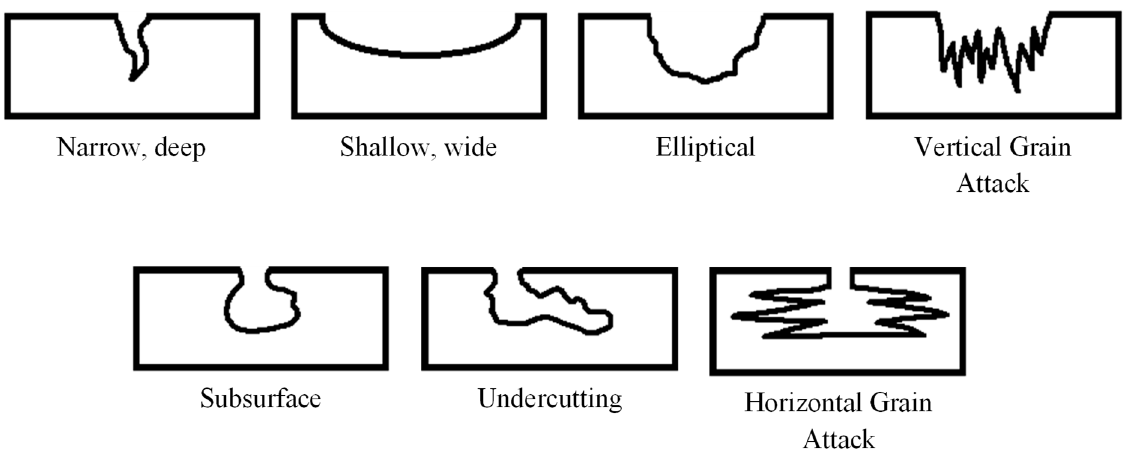
Figure 1. Types of pitting corrosion [9].